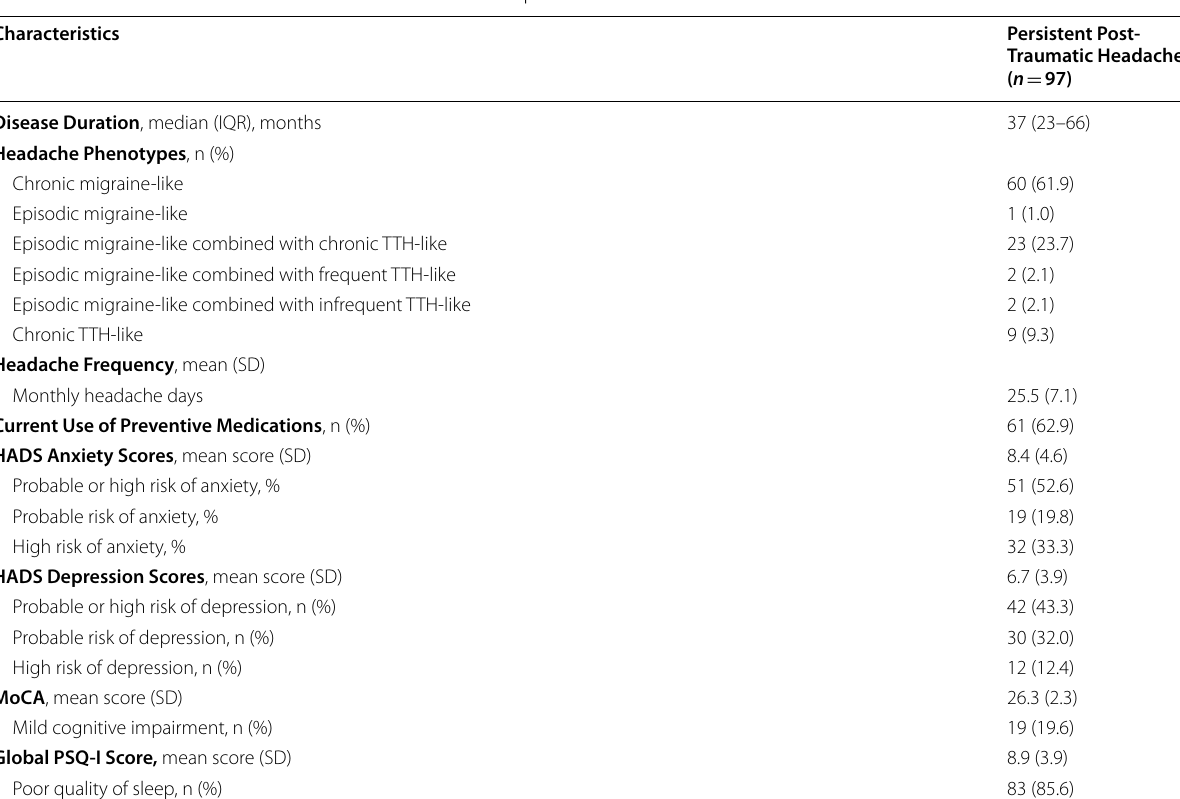
Table 2 Characteristics of the Post‑Traumatic Headache